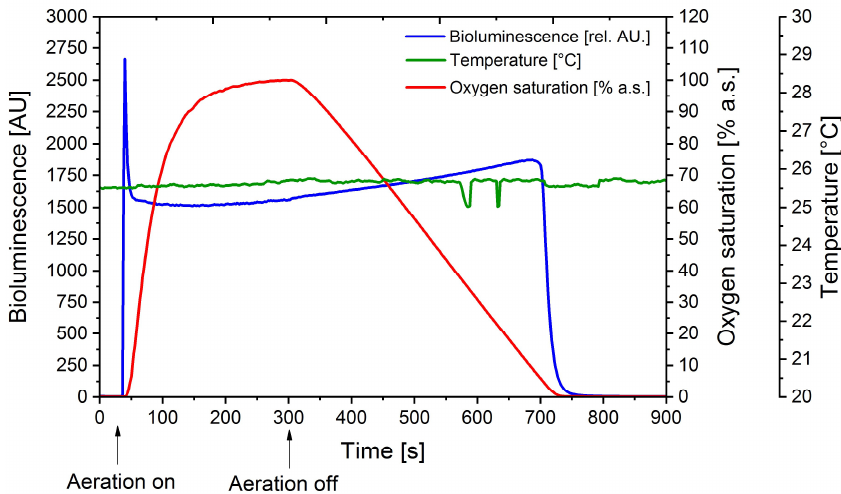
Figure 2. Determination of the influence of oxygen concentration on bioluminescence emitted by the cells in a fused-silica cuvette. A cell culture of the reporter strain carrying the yqjF :: luxCDABE fusion, pre-induced by 100mg · L − 1 2,4-DNT, was standardized to an OD 600 = 5. Temperature was kept constant at 25 ◦ C. Over the course of the experiment oxygen saturation, temperature and bioluminescence were measured and the cuvette was aerated with molecular oxygen where marked. Bioluminescence data is provided in relative arbitrary units (AU).